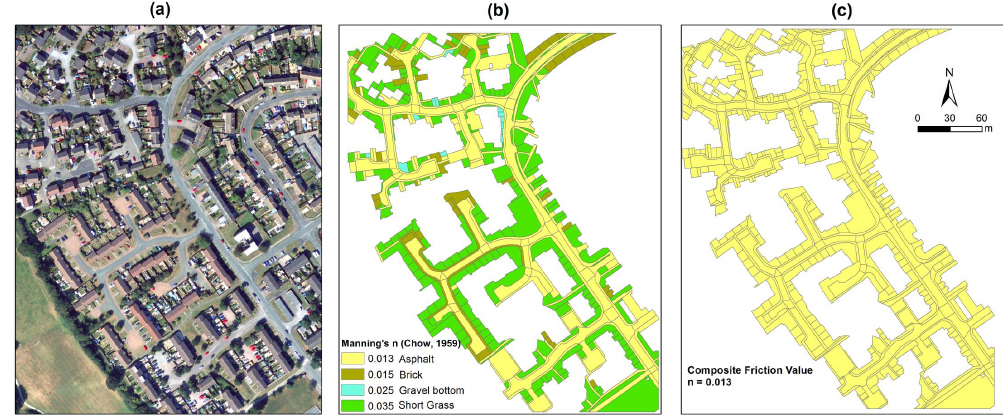
Fig. 4. Land use classification and Manning’s n value distribution (a) Google © satellite image (b) distributed Manning n value (c) single composite friction